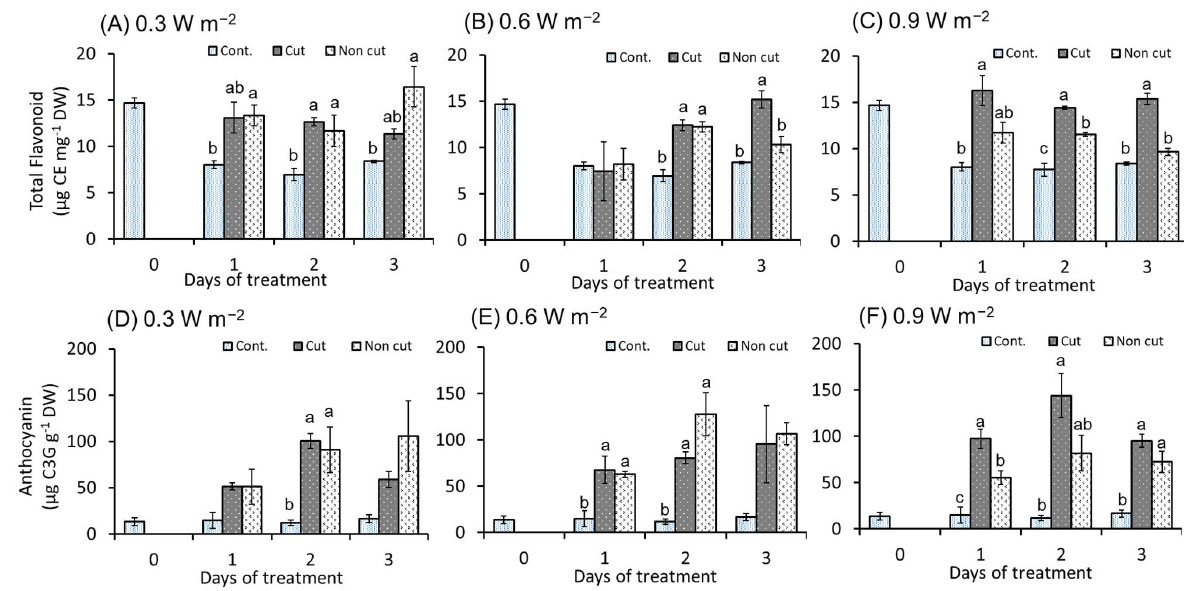
Figure 7. Total flavonoid ( A – C ) and anthocyanin concentration ( D – F ) of the third leaf of canola plant. ( A , D ) indicate 0.3 W m −2 ; ( B , E ) indicate 0.6 W m −2 ; ( C , F ) indicate 0.9 W m −2 . The UV irradiation intensity was set at 0.3, 0.6, and 0.9 W m −2 . The vertical bars indicate SE ( n = 3). Different letters indicate significant differences among treatments at p < 0.05 by Tukey–Kramer’s test.